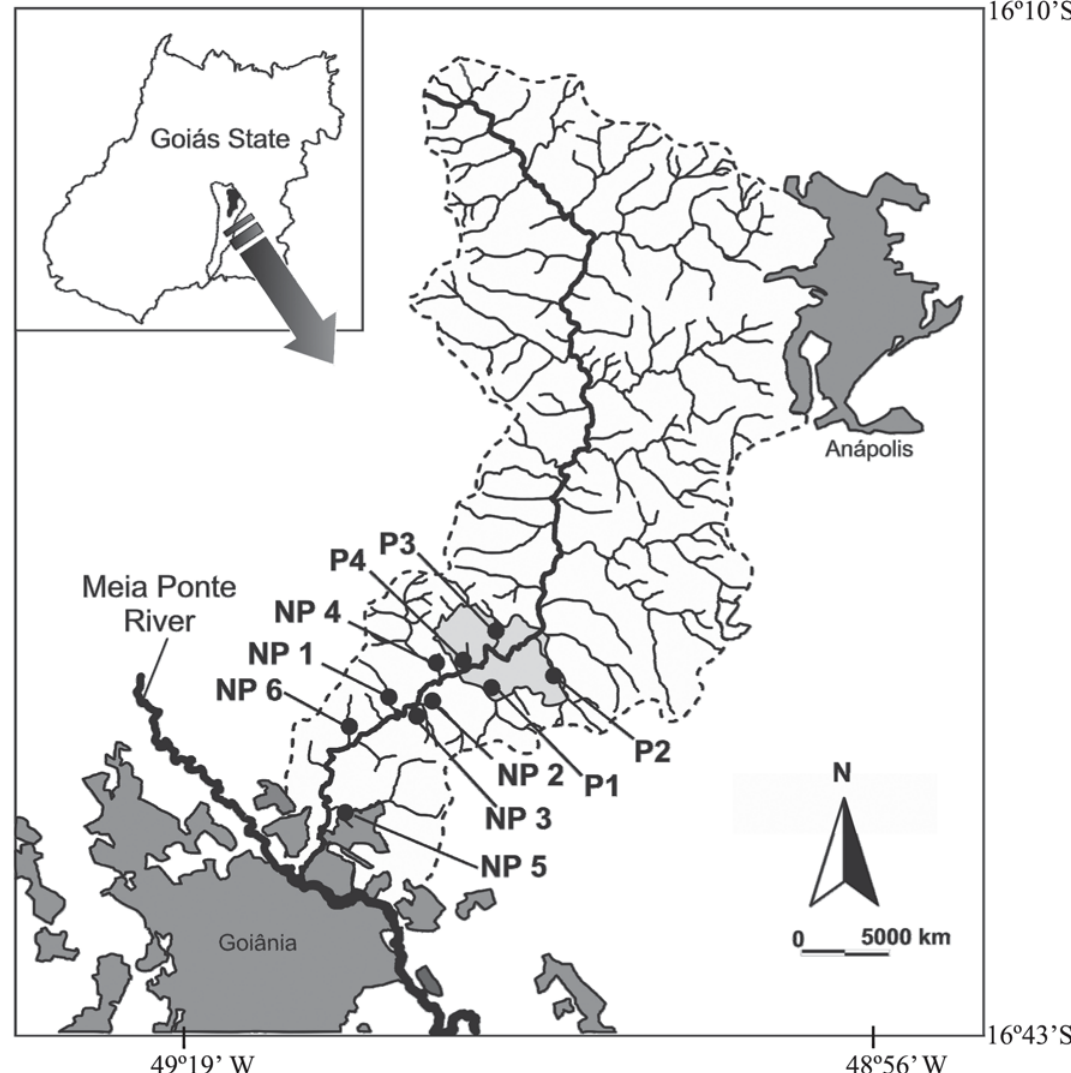
Fig. 1. Location of the streams sampled in the João Leite River basin, Goiás, Central Brazil. The broken line represents the limits of the basin. Clear grey area = Altamiro de Moura Pacheco State Park; Goiânia and Anápolis are the main cities in the basin. P1 = Macaúba; P2 = Carapina; P3 = Barreiro; P4 = Cana Brava; NP1 = Palmito; NP2 = Onça; NP3 = Unnamed Stream 3; NP4 = Bandeira; NP5 = Pedreira; NP6 = Unnamed Stream